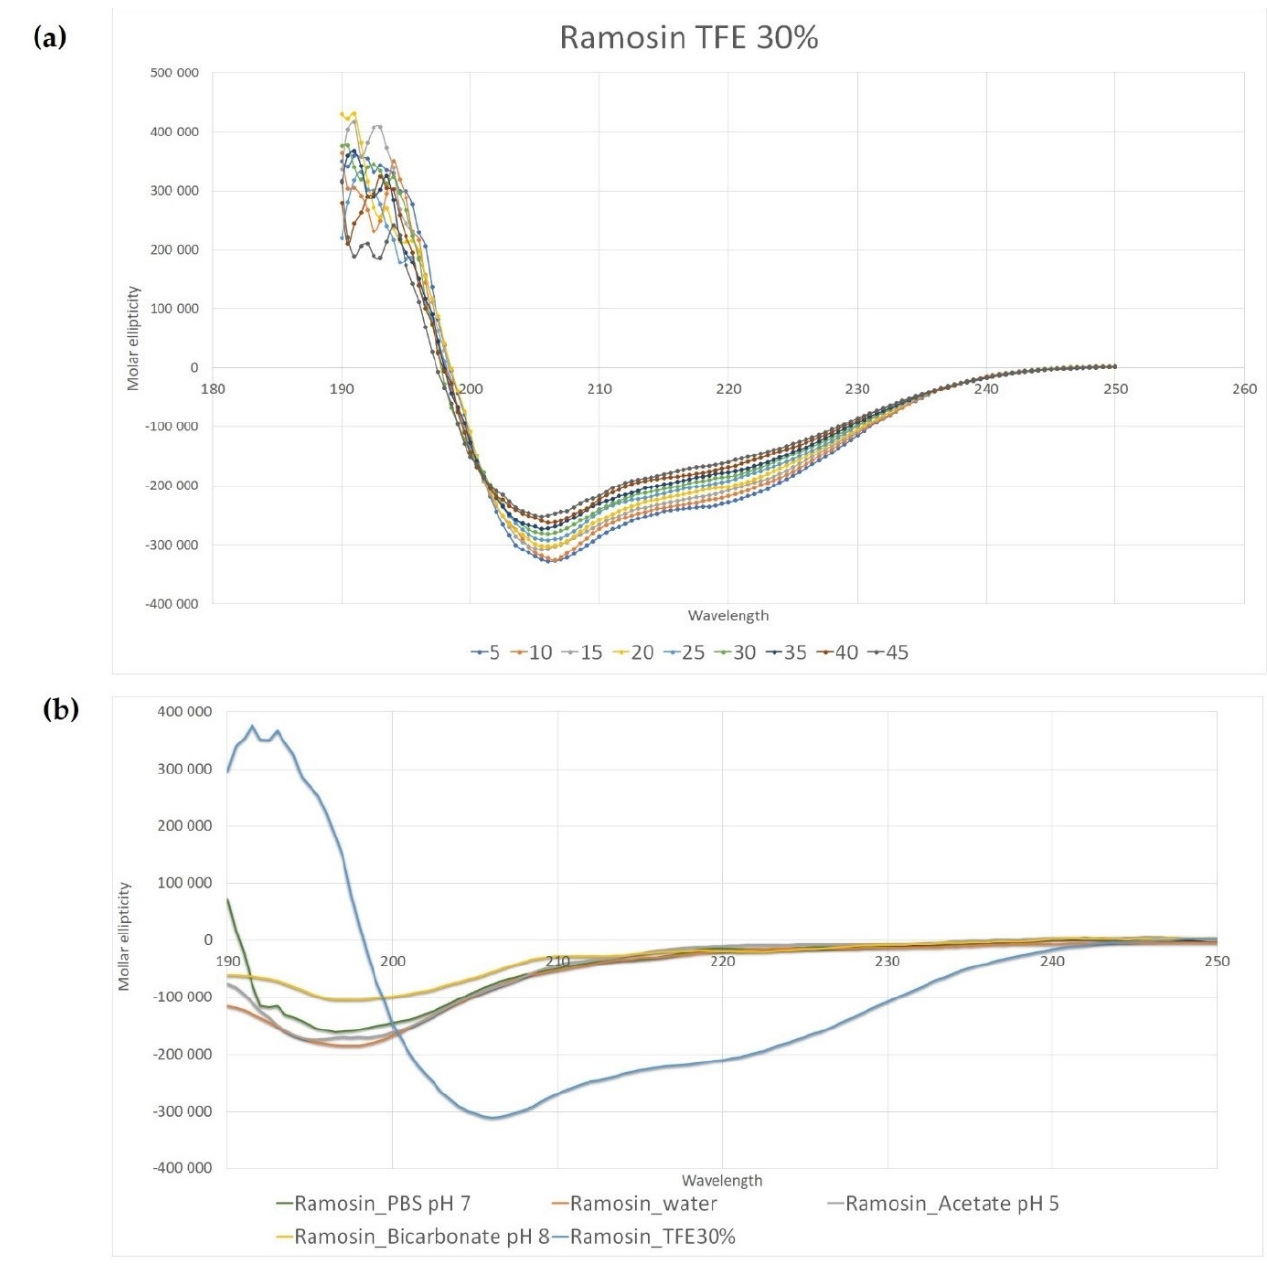
Figure 9. Circular dichroism analysis for the Ramosin peptide from Bolitoglossa ramosi . ( a ) CD spectra in TFE 30% at different temperatures. ( b ) Comparison of the spectra at different media and pH. TFE 30% is used to reduce the dielectric constant of the medium and favors intrachain interactions [51,52].